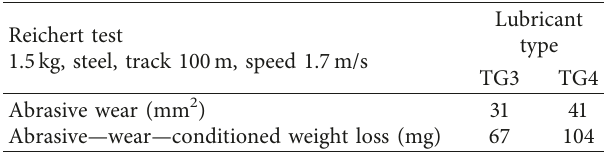
Table 3: Reichert